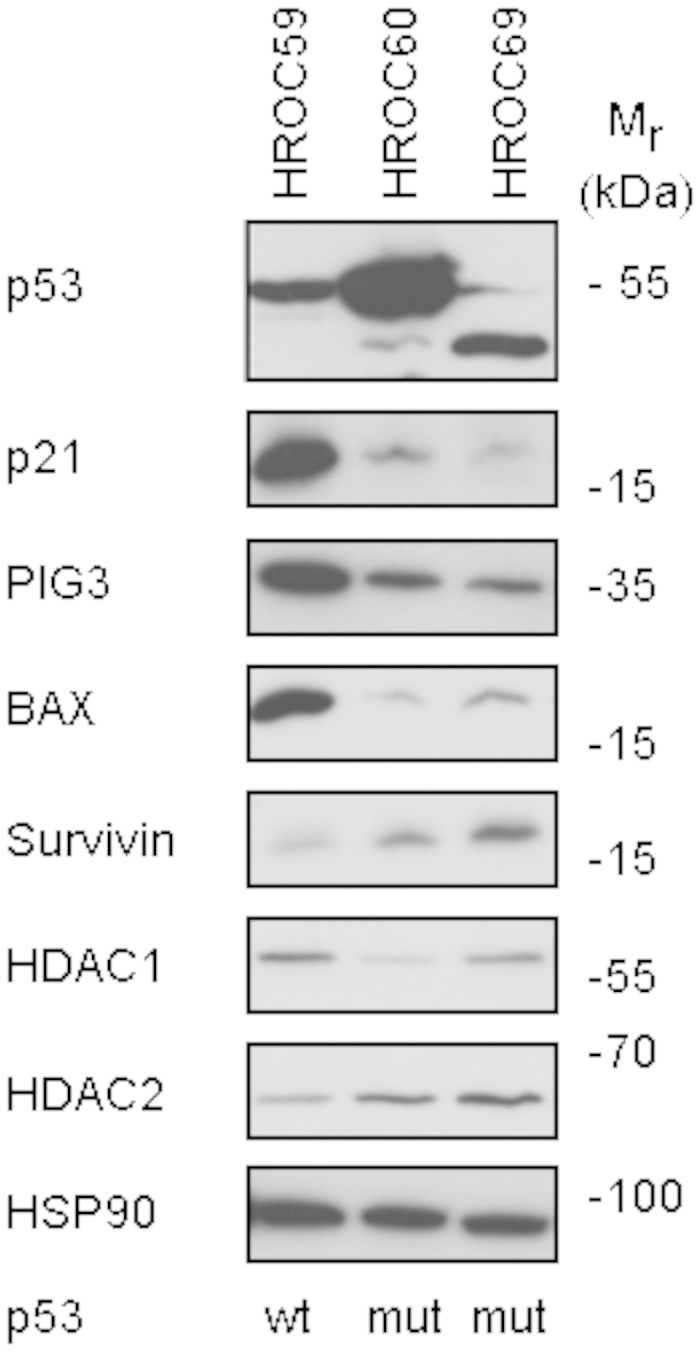
Detection of proteins involved in tumour suppression, apoptosis and stress response by immune blot.Lysates from exponentially growing cultures of the patient-derived cell lines HROC69, HROC59 and HROC60 were subjected to Western blot analysis as indicated. Expression of p53 and its target genes p21, PIG3, BAX (positively regulated) and survivin (negatively regulated), HDAC1, HDAC2, and HSP90 as the loading control were determined with specific antibodies. We used 12% gels and performed the wet transfer procedure. All antibody incubations were done overnight at 4 °C. To ensure the correct molecular weight of the proteins that we detected, we used the molecular weight standard Fermentas #SM1811.